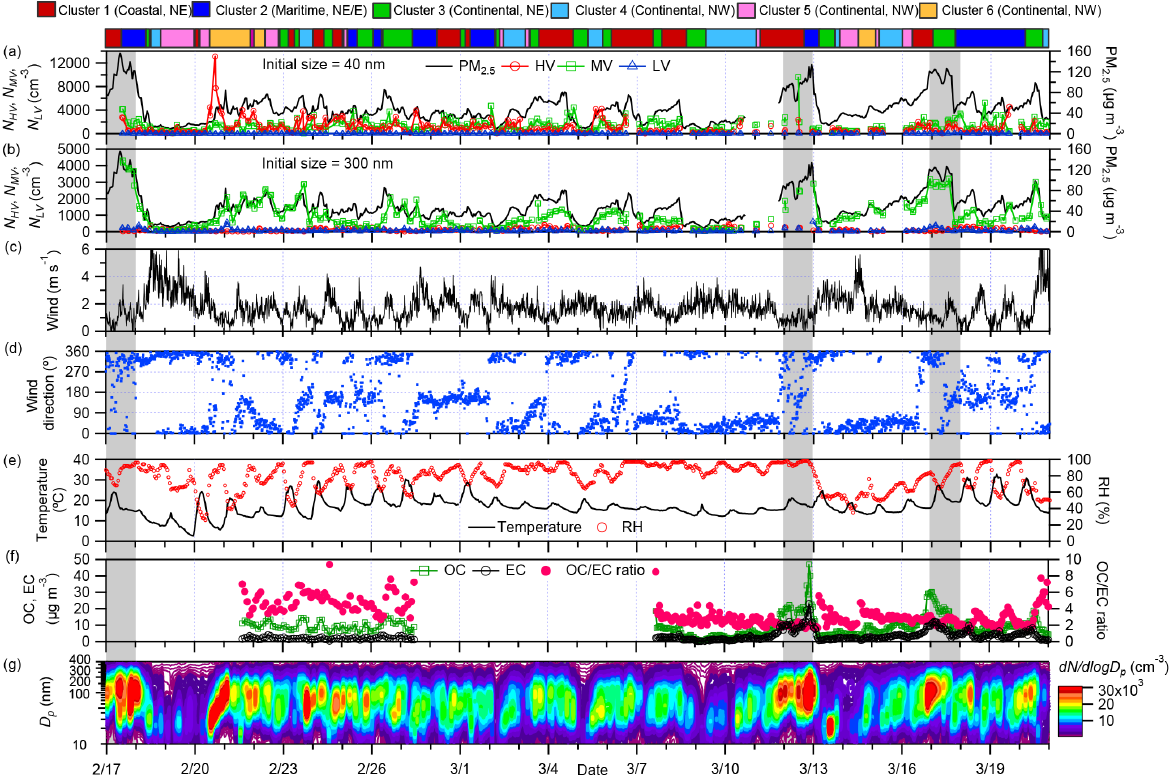
Figure 3. Temporal variation of number concentrations of HV, MV and LV in 40 and 300nm particles, PM 2 . 5 , major meteorological param- eters, OC and EC concentrations, OC-to-EC ratio and particle number size distributions in the campaign. Air mass clusters are depicted at the top and the shaded areas indicate days with daily averaged PM 2 . 5 concentrations exceeding 95µgm − 3 .